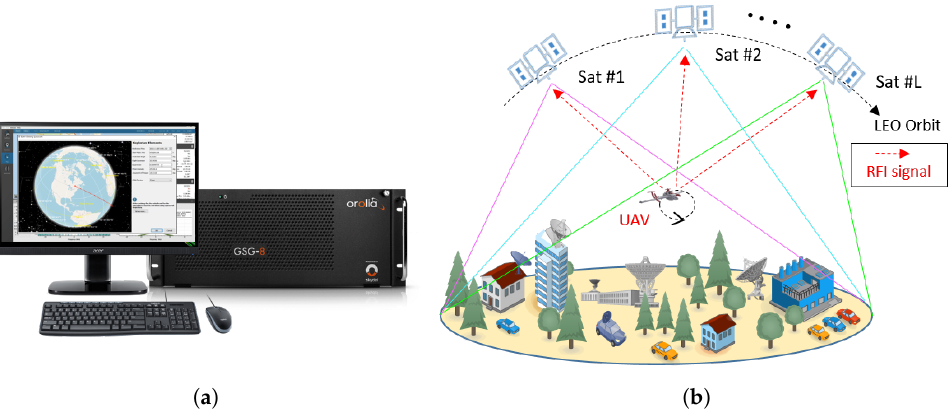
Figure 1. Modeling scenario using Orolia LEO Simulator. ( a ) Orolia’s Skydel simulator. ( b ) Pro- posed